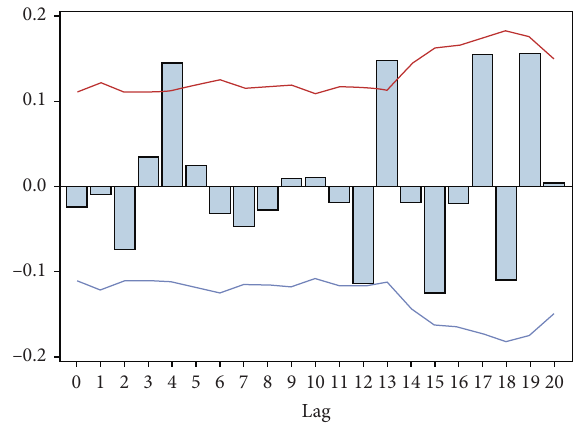
Figure 1: Impulse response weights for green finance.